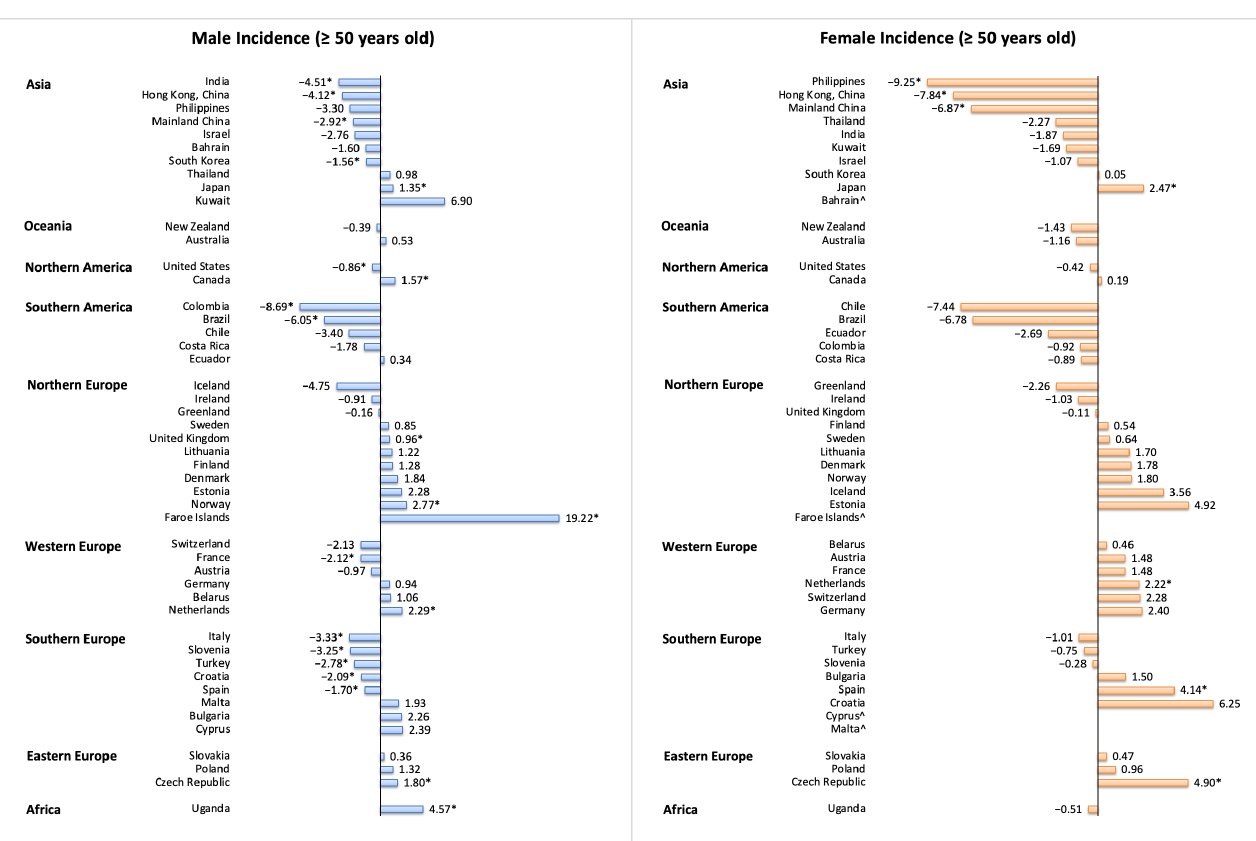
Figure 6. The AAPC of the incidence of esophageal cancer in individuals aged ≥ 50 years. AAPC, annual percentage change; * p values less than 0.05; ˆ AAPC for these countries could not be generated, as zero or missing values were identified in any year of trend analysis; the 95% confidence intervals and p values for the tests of AAPC are presented in Table